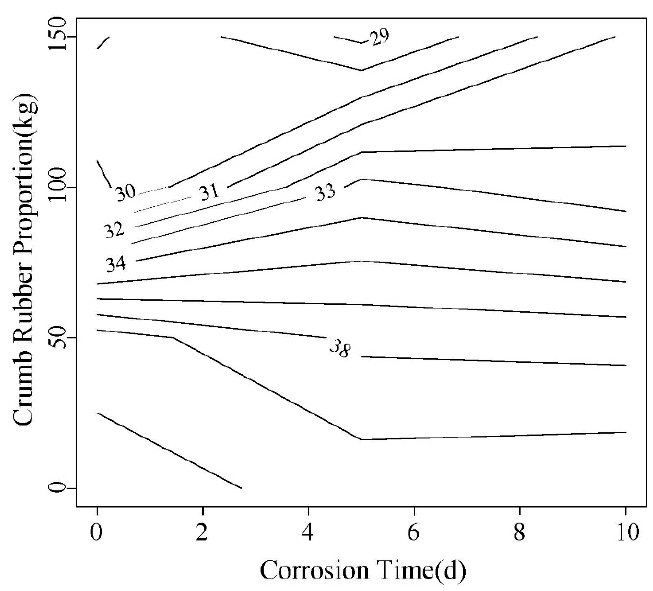
Figure 16. The equivalent load contour map of 0.55 water-cement ratio 2.5 mm displacement.